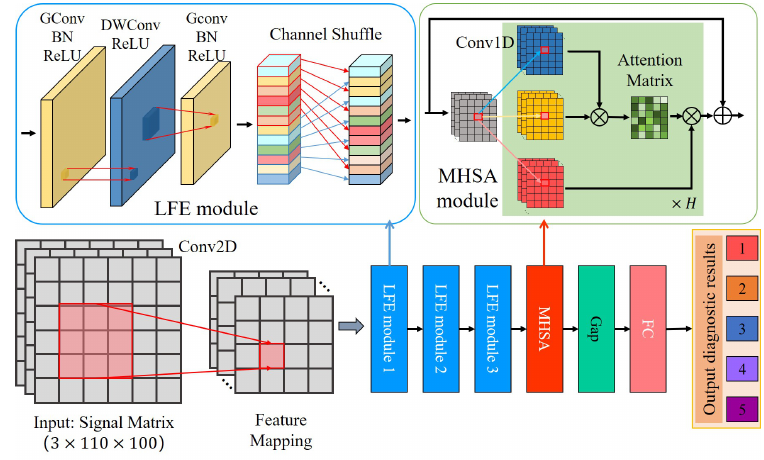
Figure 4. The architecture of LCANet for damage recognition.